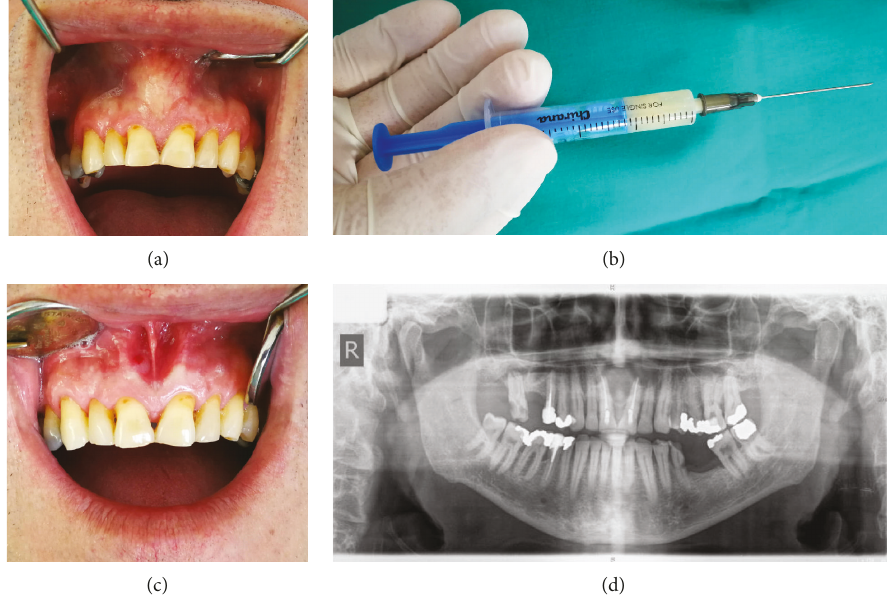
Figure 10: (a) Tumefaction of the upper vestibule above the central incisors. (b) Cystic aspirate. (c) Dent in the vestibular mucosa after the aspiration of the cystic content. (d) OPG image with a sharp shadow diverging the roots of teeth 11 and 21.